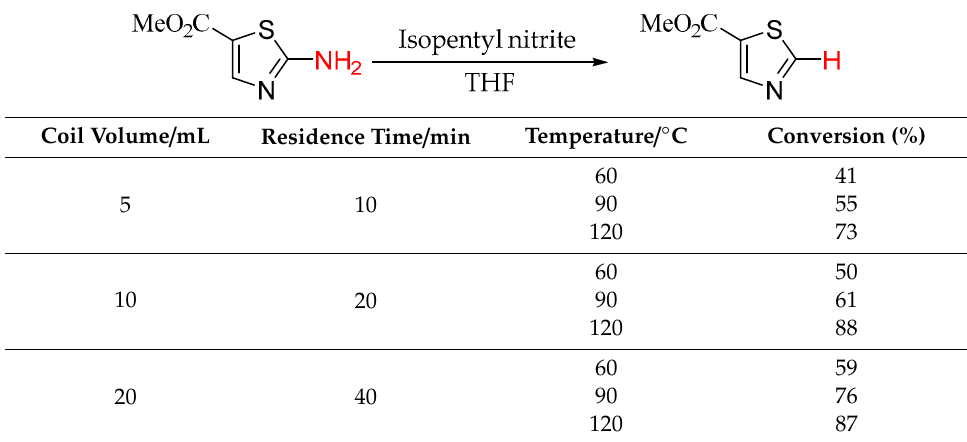
Table 4. Conversion of methyl 2-aminothiazole-5-carboxylate ( 1a ) to methyl thiazole-5-carboxylate ( 2a ) at various temperatures and reactor coil sizes in THF.